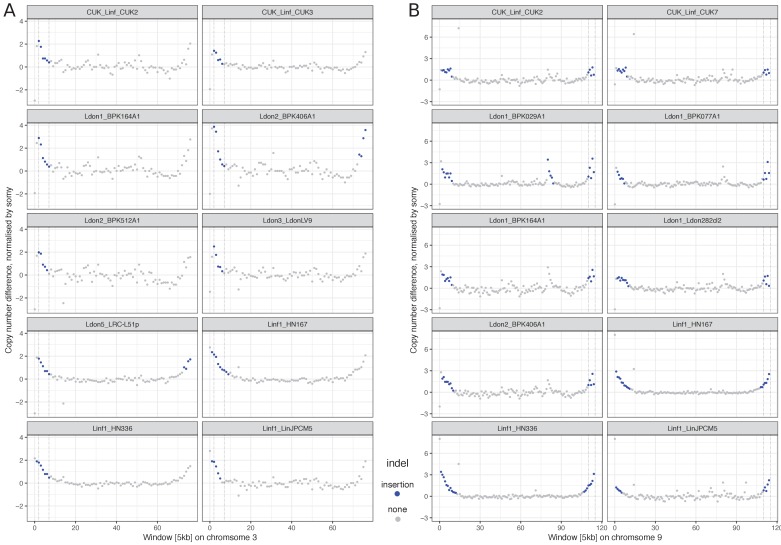
Increased coverage of samples towards chromosome ends.Samples are shown with called duplications at chromosome ends that show a gradual coverage increase. Plots show median window coverage across 5 kb windows. Called duplications are indicated by blue dots and boundaries are indicated by vertical bars. (A) Examples for chromosome 3. (B) Examples for chromosome 9.